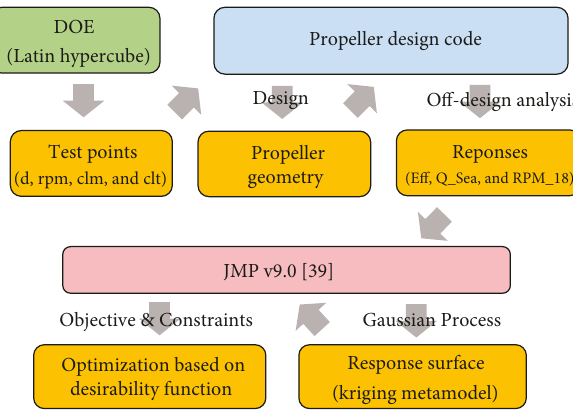
Figure 9: Schematic of optimization